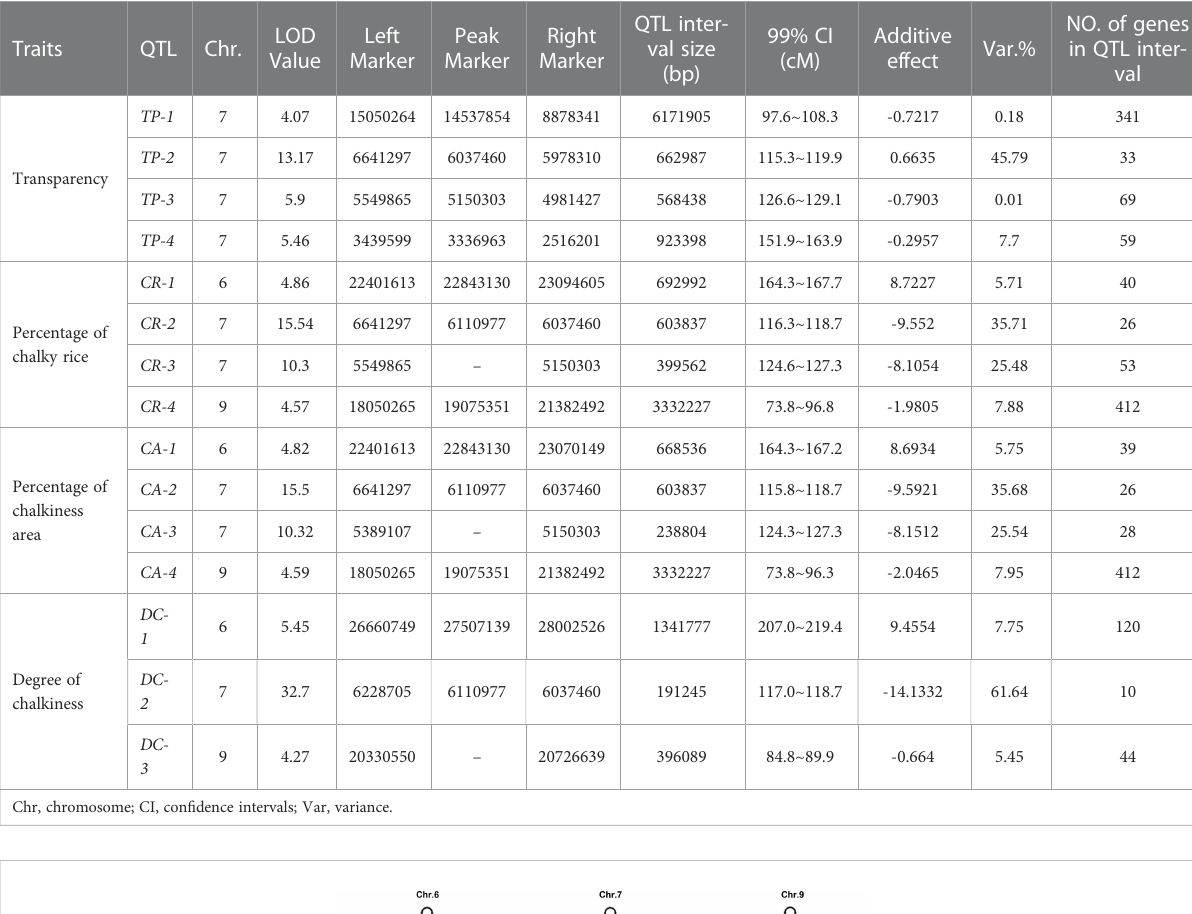
TABLE 3 QTLs identi fi ed for rice quality traits with LOD scores >4 in an F 2 population derived from a cross between Koshihikari and Nona Bokra rice varieties.